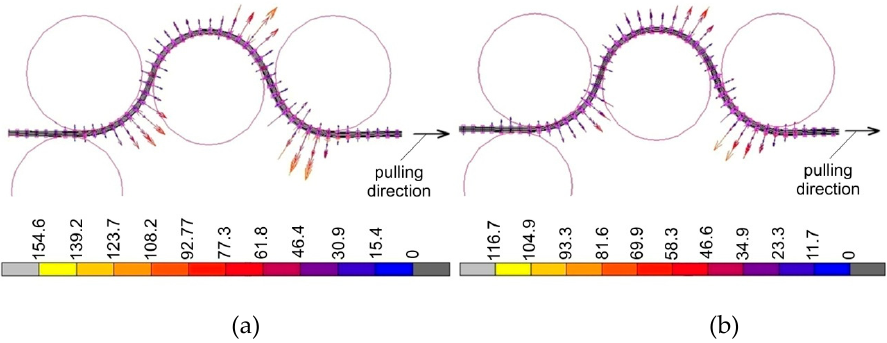
Figure 14. Distribution of normal stress in the specimen material for a specimen width w = 20 mm, and drawbead height of h = 18 mm under ( a ) friction and ( b ) frictionless conditions.